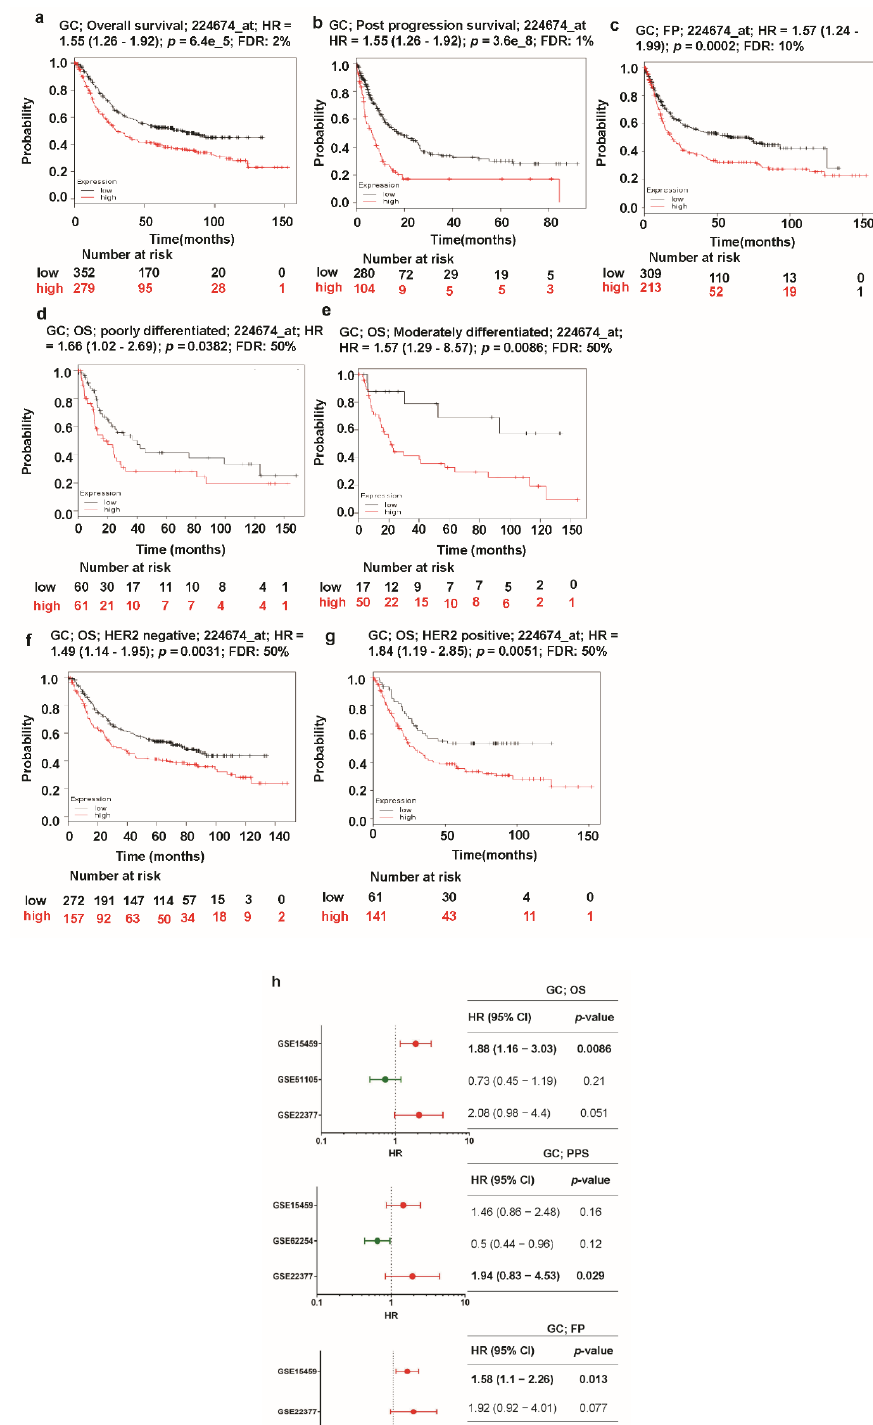
Figure 6. Kaplan–Meier plot of the relationship of TTYH3 gene expression and survival in GC / SC patients: The survival curves demonstrate patient survival with high (red) and low (black)